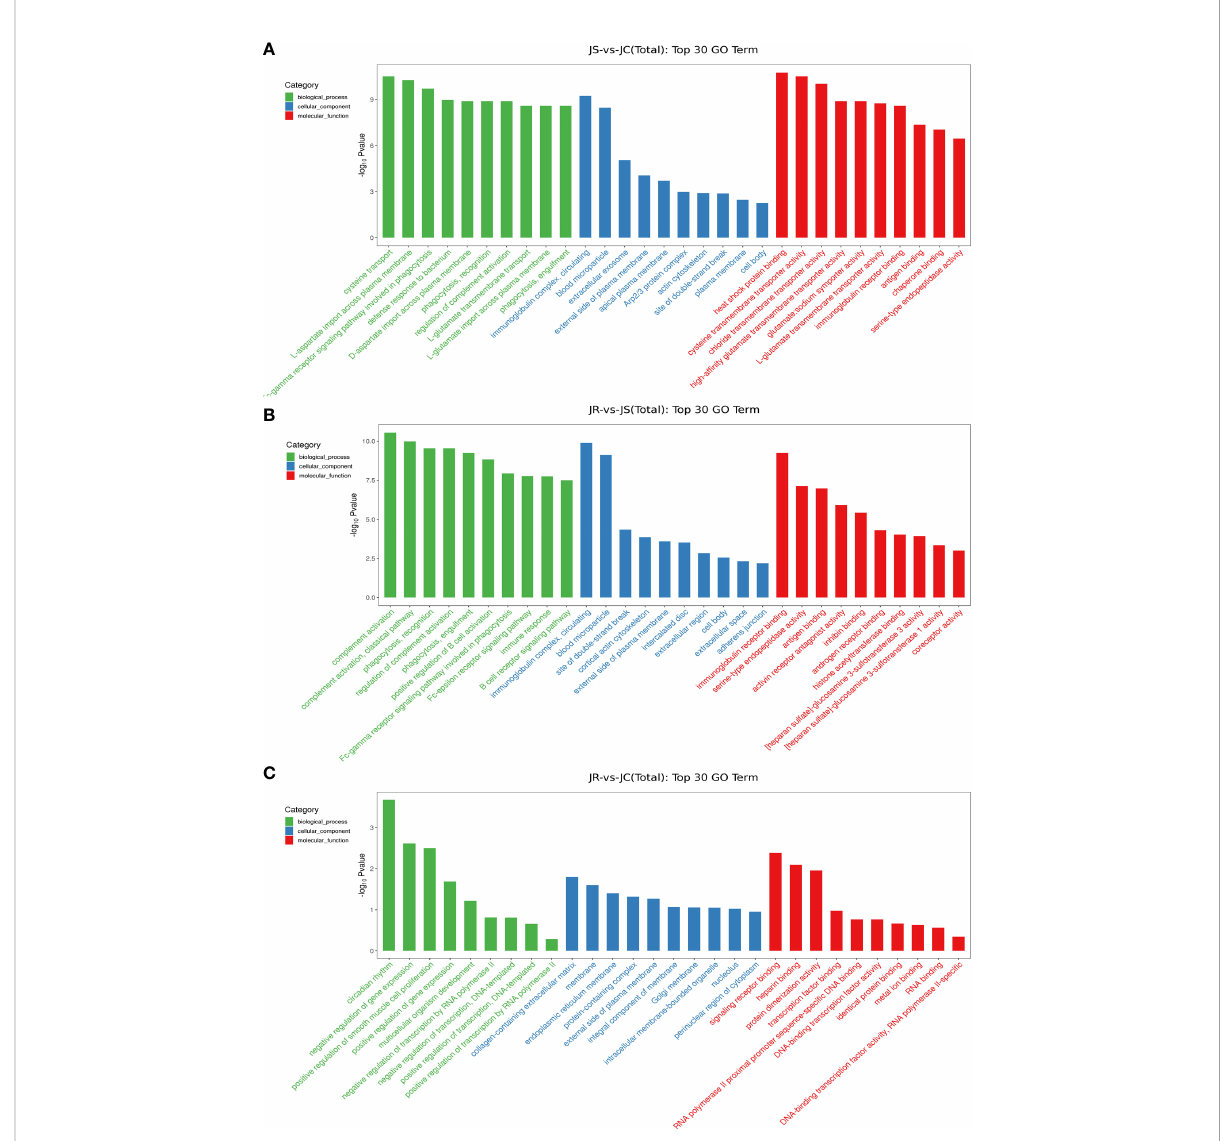
FIGURE 4 GO term analysis of the differentially expressed lncRNAs in chicken cecal tissues of different groups during E. tenella infection. (A) JS vs JC group. (B) JR vs JS group. (C) JR vs JC